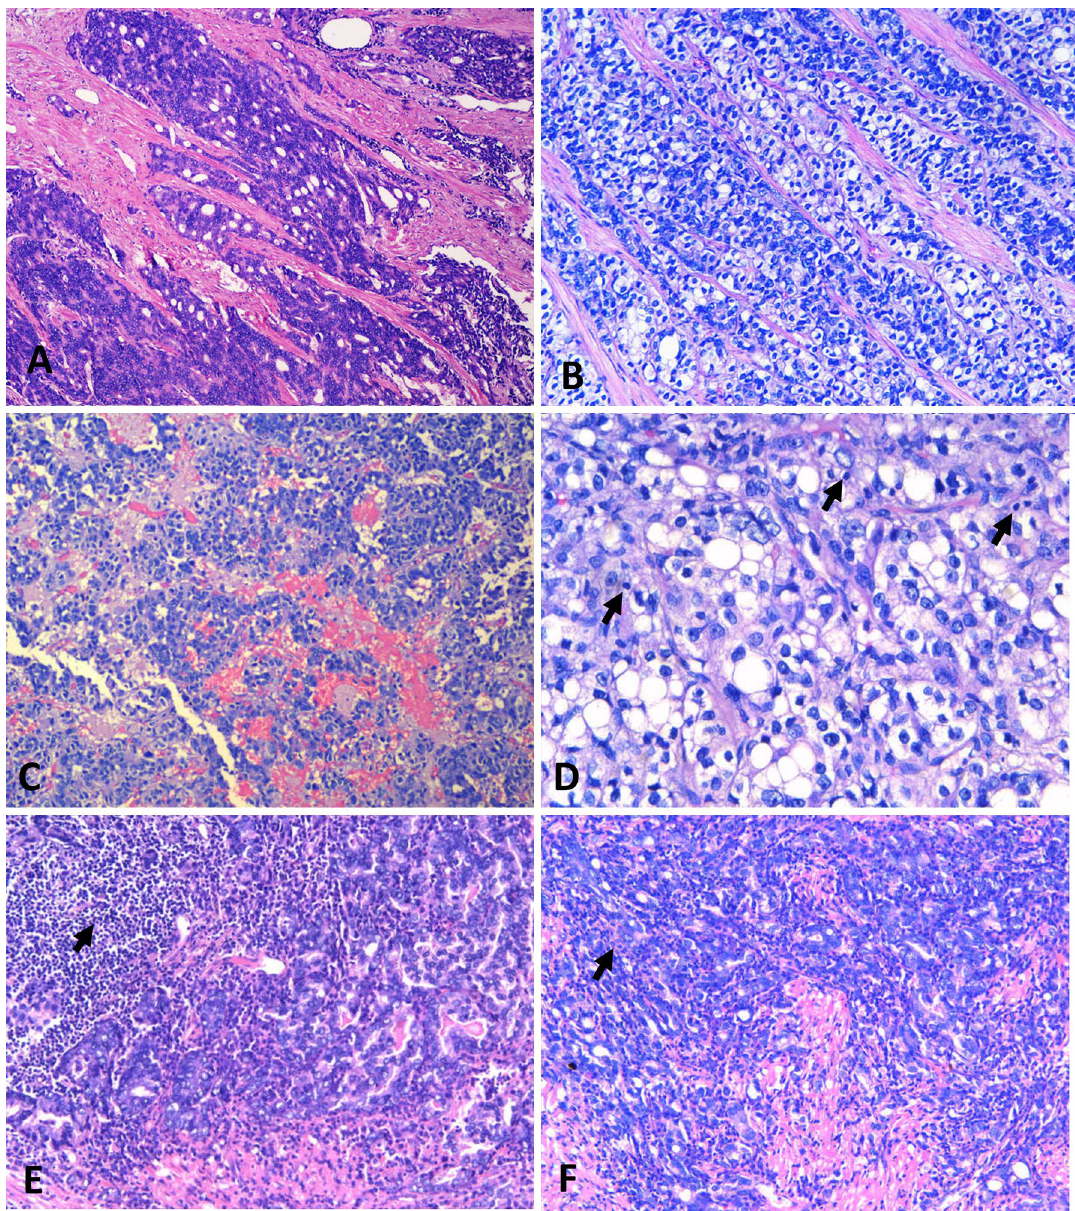
Figure 1. Representative histopathological images of EBV-positive and EBV-negative prostate adenocarcinoma of the acinar type showing the Gleason pattern where higher Gleason scores are found in EBV-positive prostate carcinoma tissues as compared to EBV-negative prostate carcinoma tissues. The histopathological images show: ( A) EBV-positive prostate adenocarcinoma, Gleason score of 9 (4 + 5), with a prognostic grade group 5 (H&E; original magnification: × 100). ( B) EBV-negative prostate adenocarcinoma, Gleason score of 8 (4 + 4), with a prognostic grade group 4 (H&E; original magnification: 200X). ( C) EBV-positive prostate adenocarcinoma, Gleason score of 9 (4 + 5), with a prognostic grade group 5 (H&E; original magnification: × 100). (D) EBV- positive prostatic adenocarcinoma, Gleason score of 9 (4 + 5) showing the intratumoral lymphocytes (ITL) infiltration in the tumor marked with black arrows (H&E; 400X). ( E) EBV-negative prostate adenocarcinoma, Gleason score of 9 (4 + 5), with a prognostic grade group 5 with stromal lymphocytic infiltration (black arrows arrow) (H&E; original magnification: × 200) ( F) EBV-negative prostate adenocarcinoma, Gleason score of 9 (4 + 5), with a prognostic grade group 5 with the intratumoral lymphocytic infiltration. (H&E; original magnification: ×